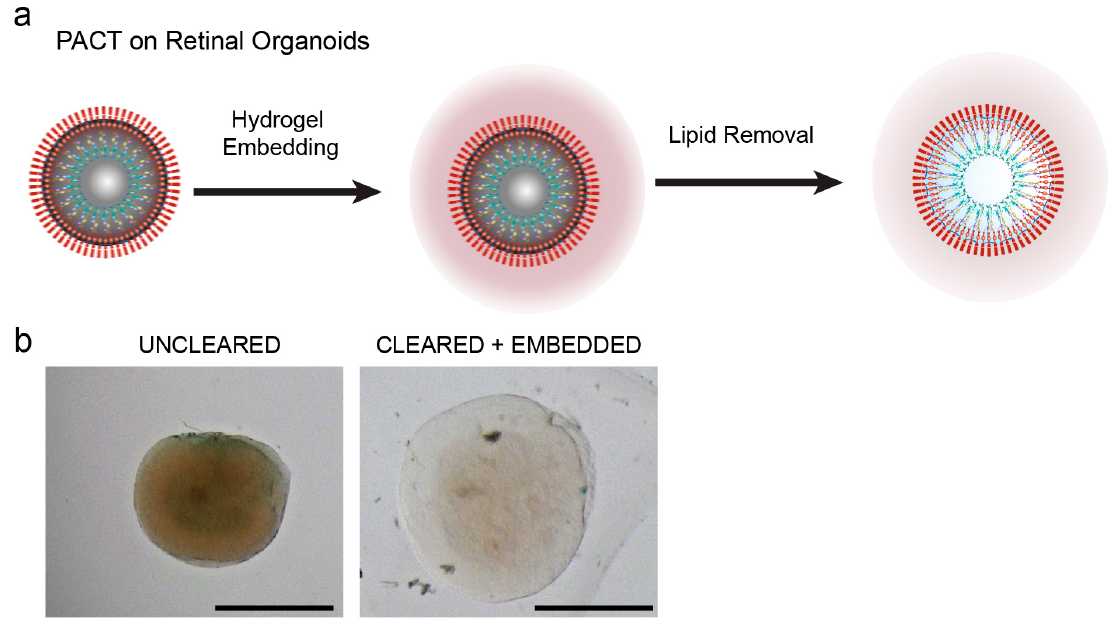
Figure 1. Passive clarity technique (PACT) protocol optimized for the retinal organoid. ( a ) Schematic workflow of retinal organoid-clearing with PACT. Initially, organoids (left) are embedded in a hydrogel (middle). Membrane lipids are washed away using a detergent solution to finally obtain an optically transparent sample (right). ( b ) Comparison of an uncleared retinal organoid (day 106) with a hydrogel-embedded organoid cleared for 5 days using optimized PACT. Both organoids are immersed in 80% glycerol. Scale bars: ( b ) 500 µm.